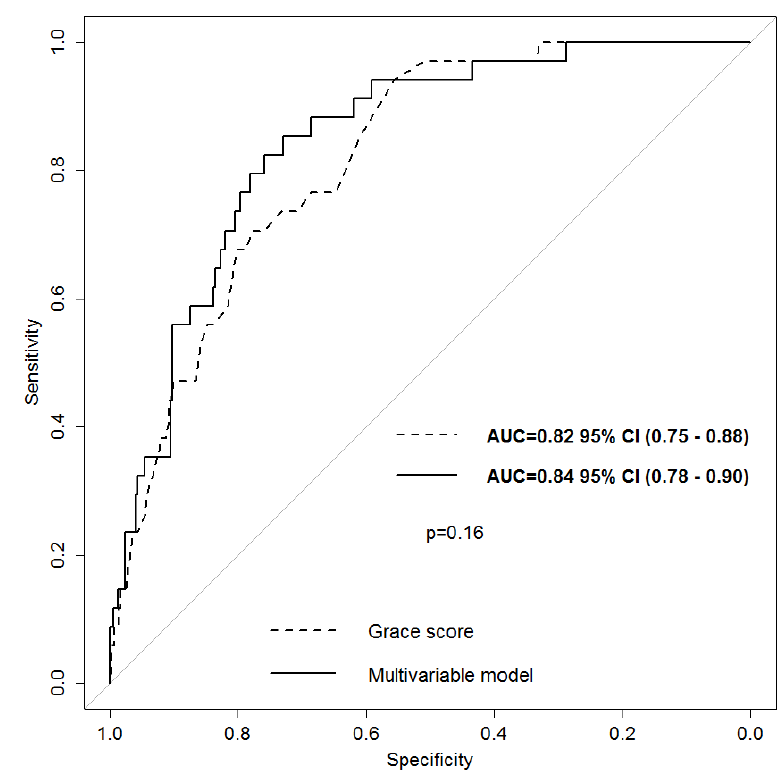
Figure 2. ROC curve of our multivariate model compared to the ROC curve of the GRACE score for mortality at 1 year.